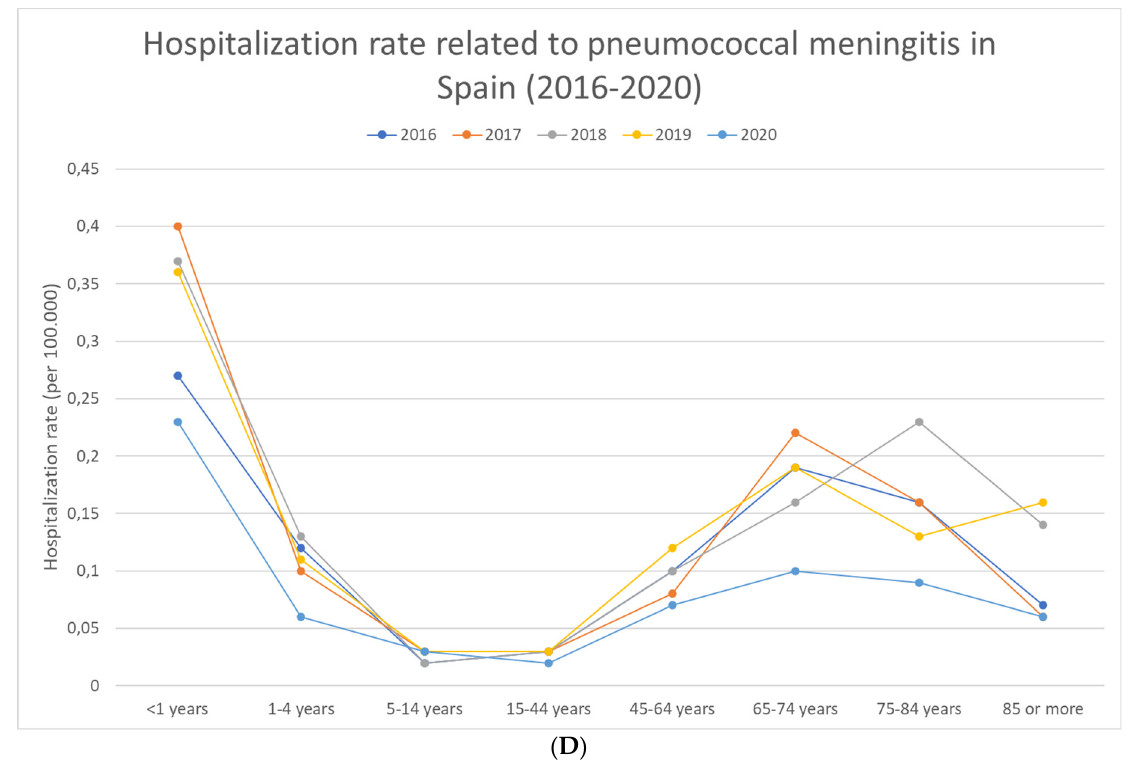
Figure 1. ( A ): Hospitalization rate related to pneumococcal infection by age group and year of study in Spain (2016-2020). ( B ) Hospitalization rate related to pneumococcal pneumonia by age group and year of study in Spain (2016-2020). ( C ) Hospitalization rate related to pneumococcal sepsis by age group and year of study in Spain (2016-2020). ( D ) Hospitalization rate related to pneumococcal meningitis by age group and year of study in Spain (2016-2020).